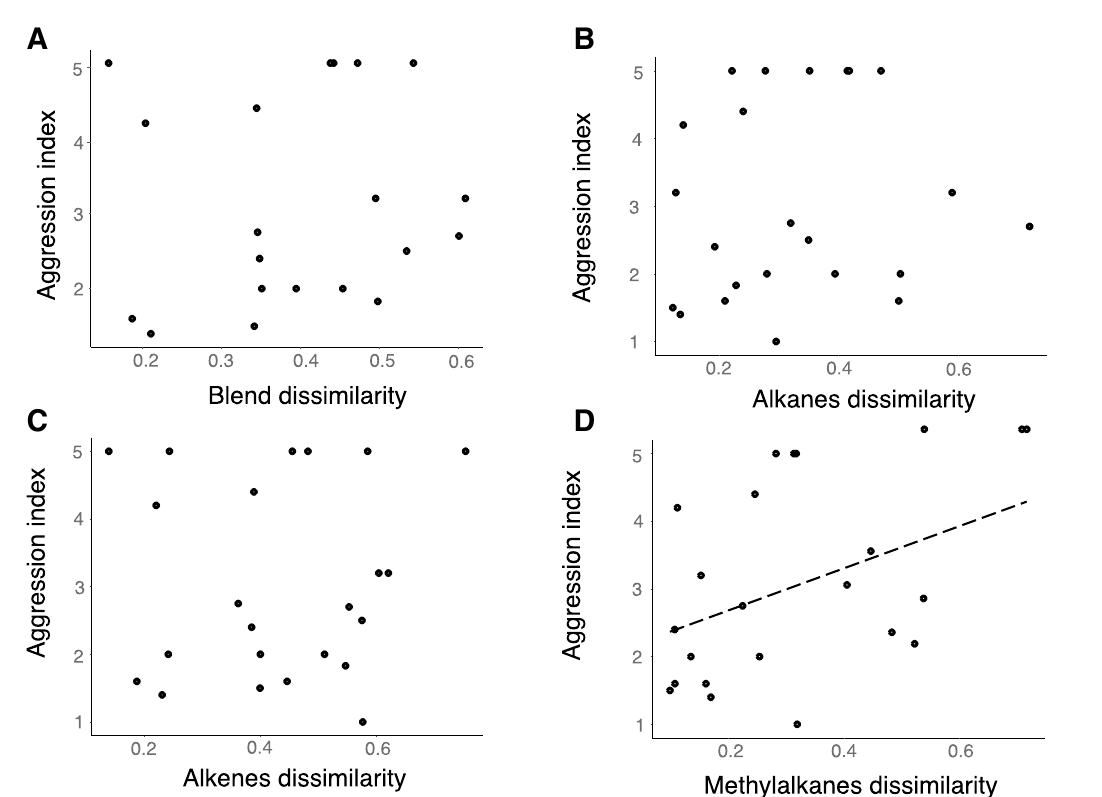
Figure 4. Relationship between ants’ CHC profile dissimilarity and the spatial distance between nests. ( A ) chemical dissimilarity using total CHC blend; ( B ) chemical dissimilarity using Alkanes only; ( C ) chemical dissimilarity using Alkenes only; ( D ) chemical dissimilarity using Methyl alkanes only. The solid line represents the linear regression fit to the data. Each point represents a pair of ant nests (the same ones submitted to behavioral trials, N =